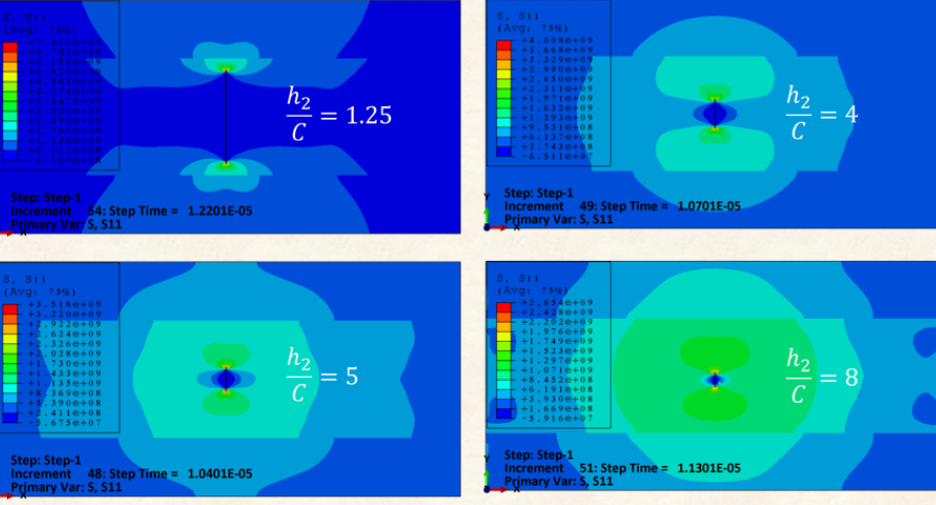
Figure 4. Crack length effect on stress distribution for PZT-4